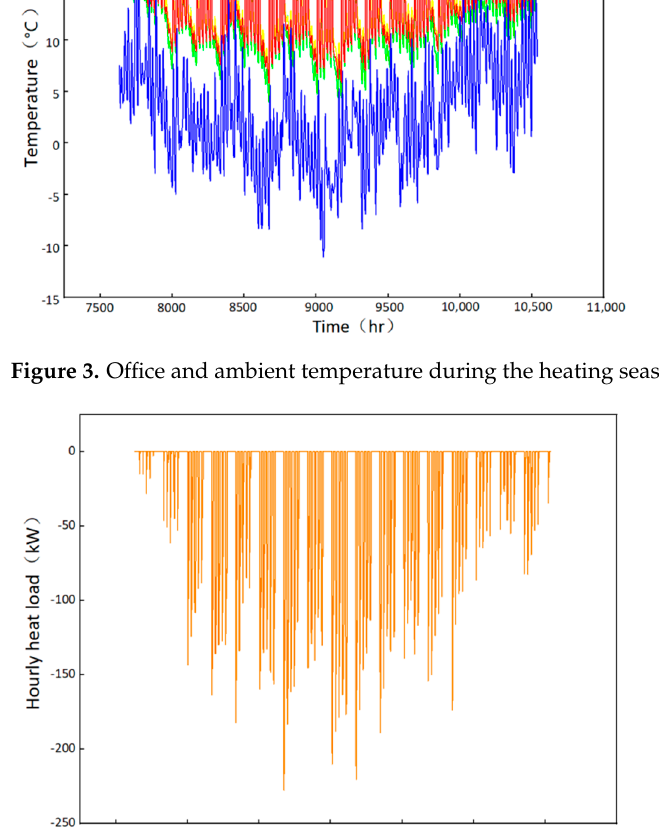
Figure 4. Hourly heat load during the heating season.